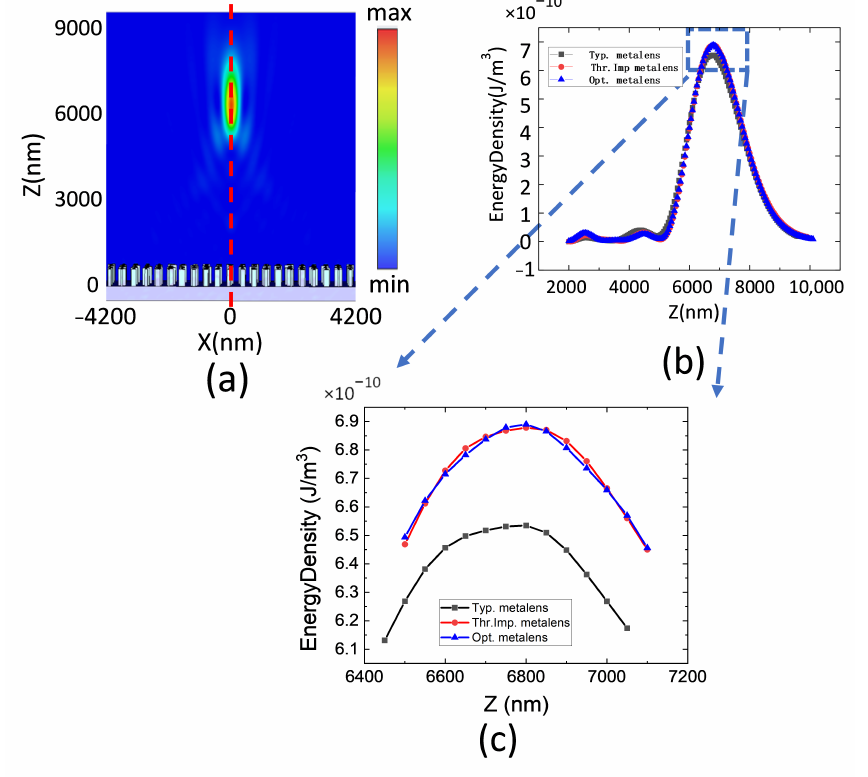
Figure 4. (Color online) The light focusing results of the metalenses. ( a ) The energy density of the focused light for the conventional metalens. ( b , c ) The energy density along the optical axis. The lines are used to guide the